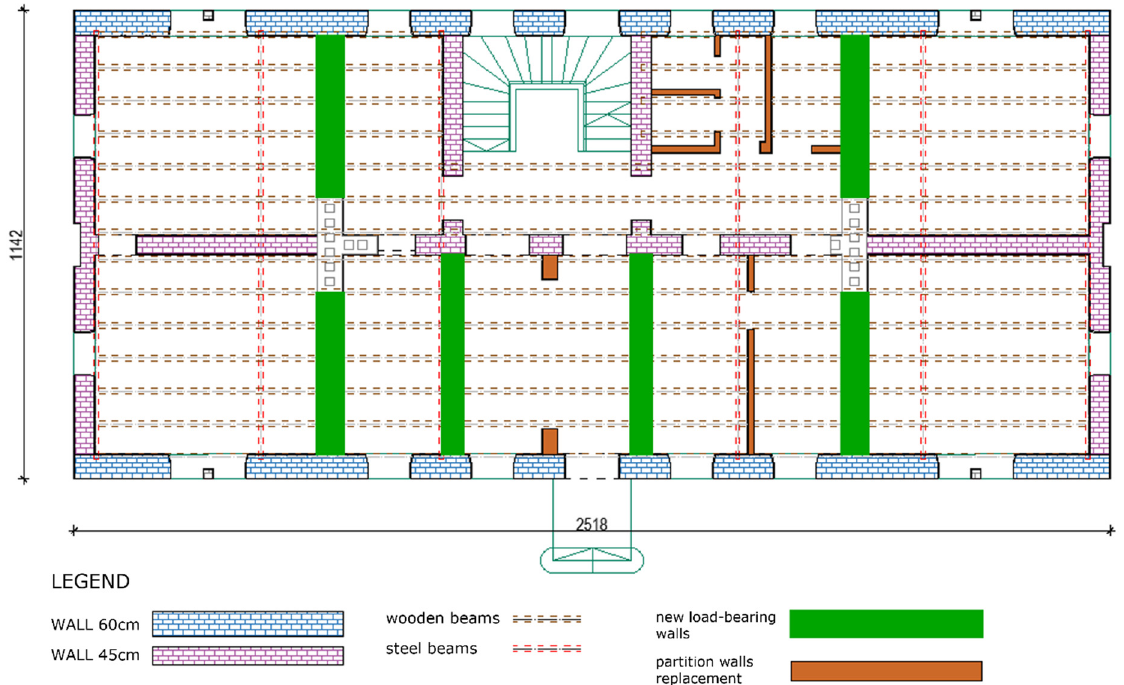
Figure 22. Proposal for the position of the new load-bearing walls and proposal for the removal and replacement of partition walls.